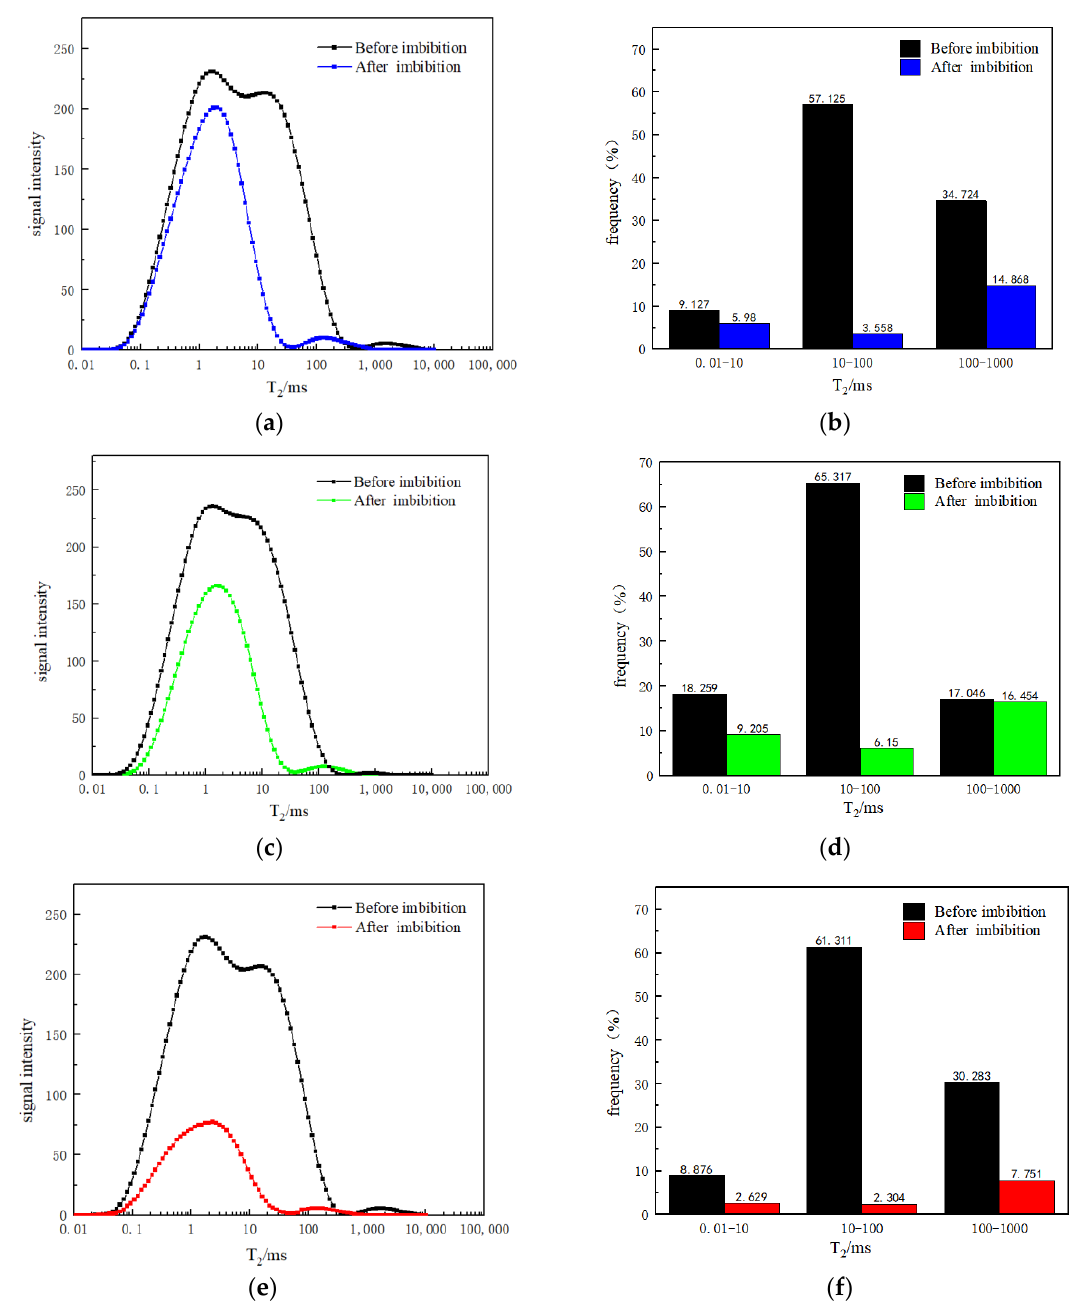
Figure 4. ( a ) T 2 spectrum before and after black card imbibition; ( b ) fluid distribution frequency before and after black card imbibition; ( c ) T 2 spectrum before and after emulsion imbibition; ( d ) fluid distribution frequency before and after emulsion imbibition; ( e ) T 2 spectrum before and after water imbibition; ( f ) water fluid distribution frequency before and after imbibition.